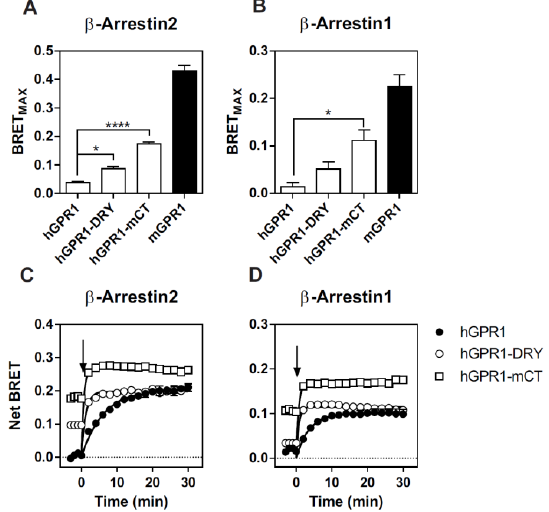
Figure 8. R 3.50 and the C-terminus of mGPR1 are involved in its interaction with β -arrestins. ( A , B ) BRET MAX values derived from BRET titration curves obtained with HEK293T cells transfected with a constant amount of β -arrestin2- R Luc ( A ) or β -arrestin1- R Luc ( B ) and increasing amounts of hGPR1-Venus, hGPR1-DRY-Venus, hGPR1-mCT or mGPR1-Venus. ( C , D ) Real-time measurement of BRET signal in HEK293T cells expressing β -arrestin2- R Luc ( C ) or β -arrestin1- R Luc ( D ) in com- bination with hGPR1-Venus ( ○ ), hGPR1-DRY-Venus ( ■ ) or hGPR1-mCT-Venus ( □ ), in basal condi- tions and after stimulation with 100 nM chemerin. Results are expressed as Net BRET correspond- ing to the BRET signal measured between the donor and the acceptor minus the BRET signal meas- ured with the donor only. Data represent the mean ± SEM of at least three independent experi- ments. * p < 0.05; *** p < 0.0001.